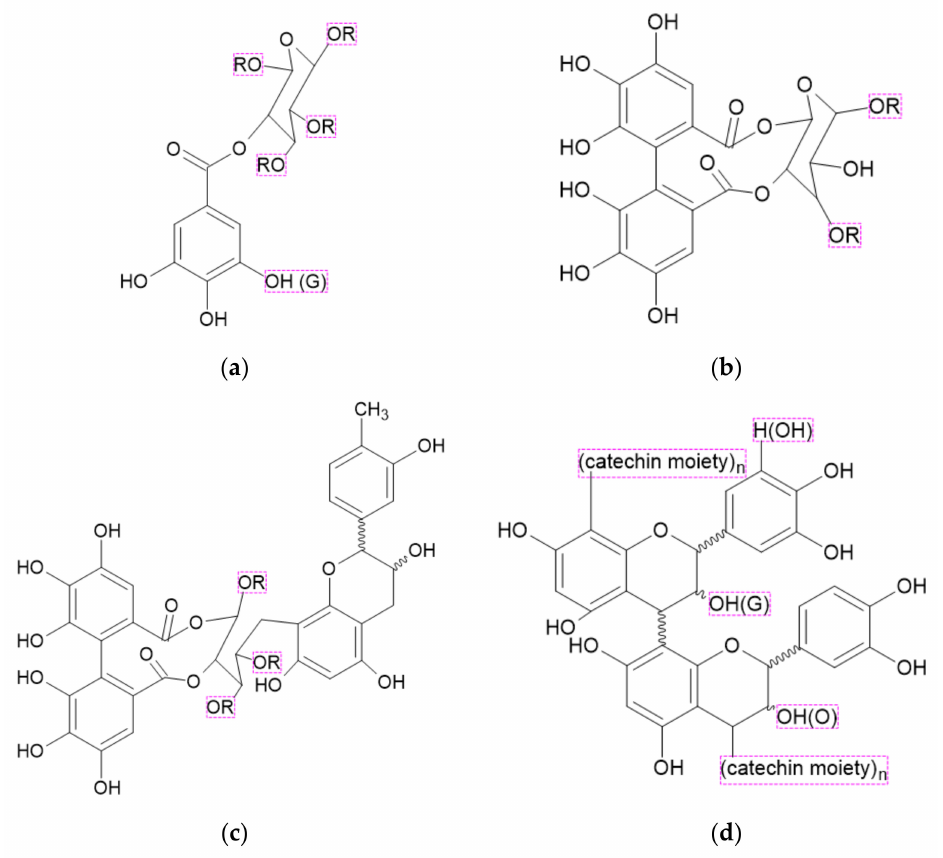
Figure 7. Structures of different tannins [34]: ( a ) gallotannin; ( b ) ellagitannin; ( c ) complex tannin; ( d ) condensed